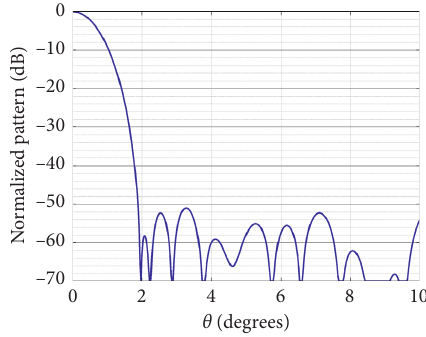
Figure 17: The two-way array pattern for N